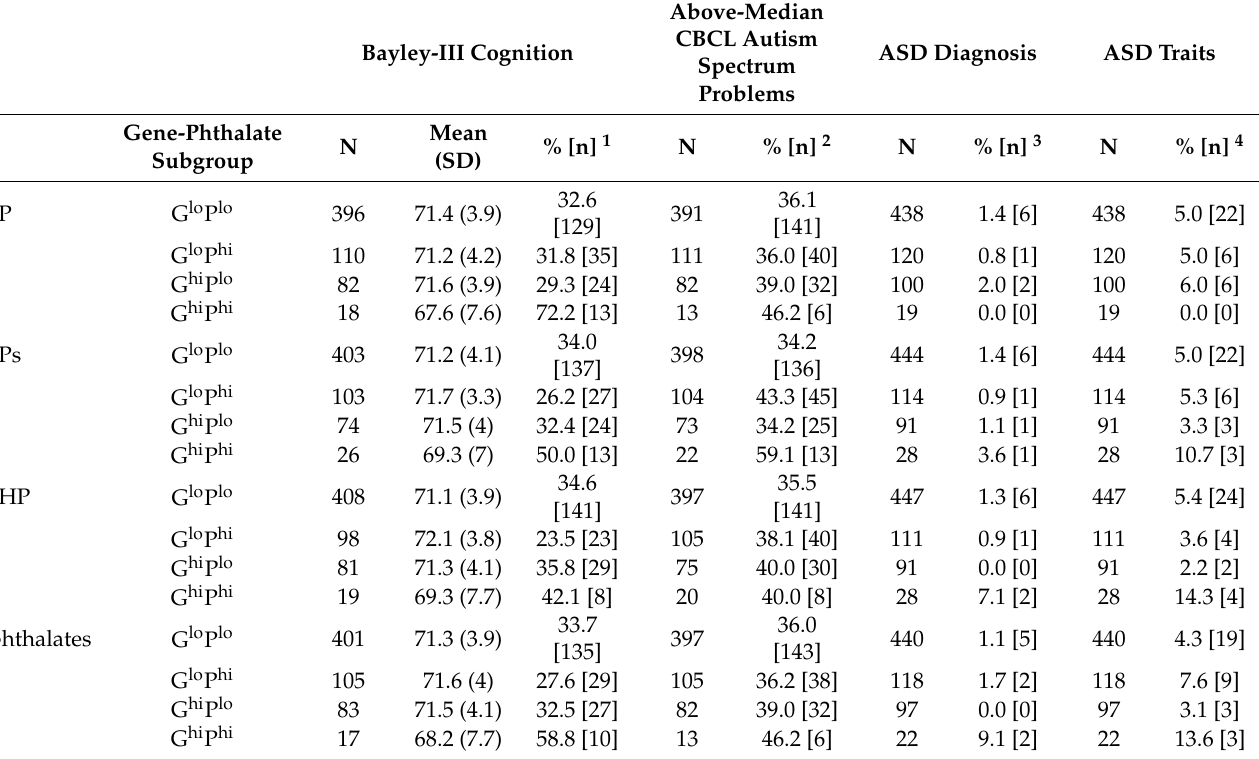
Table 5. Interplay on the additive scale between genetic pathway function score for oxidative stress response (gPFS ox ) and prenatal phthalate levels against neurodevelopmental outcomes.